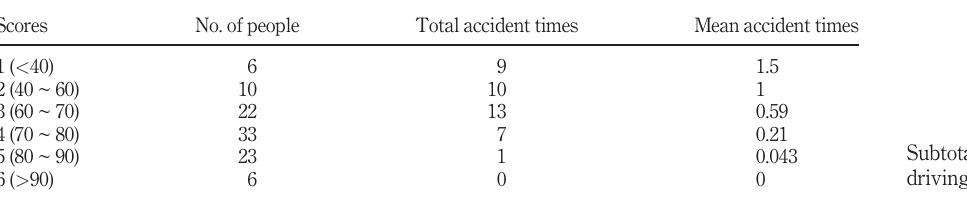
Table VI. Subtotal scores of